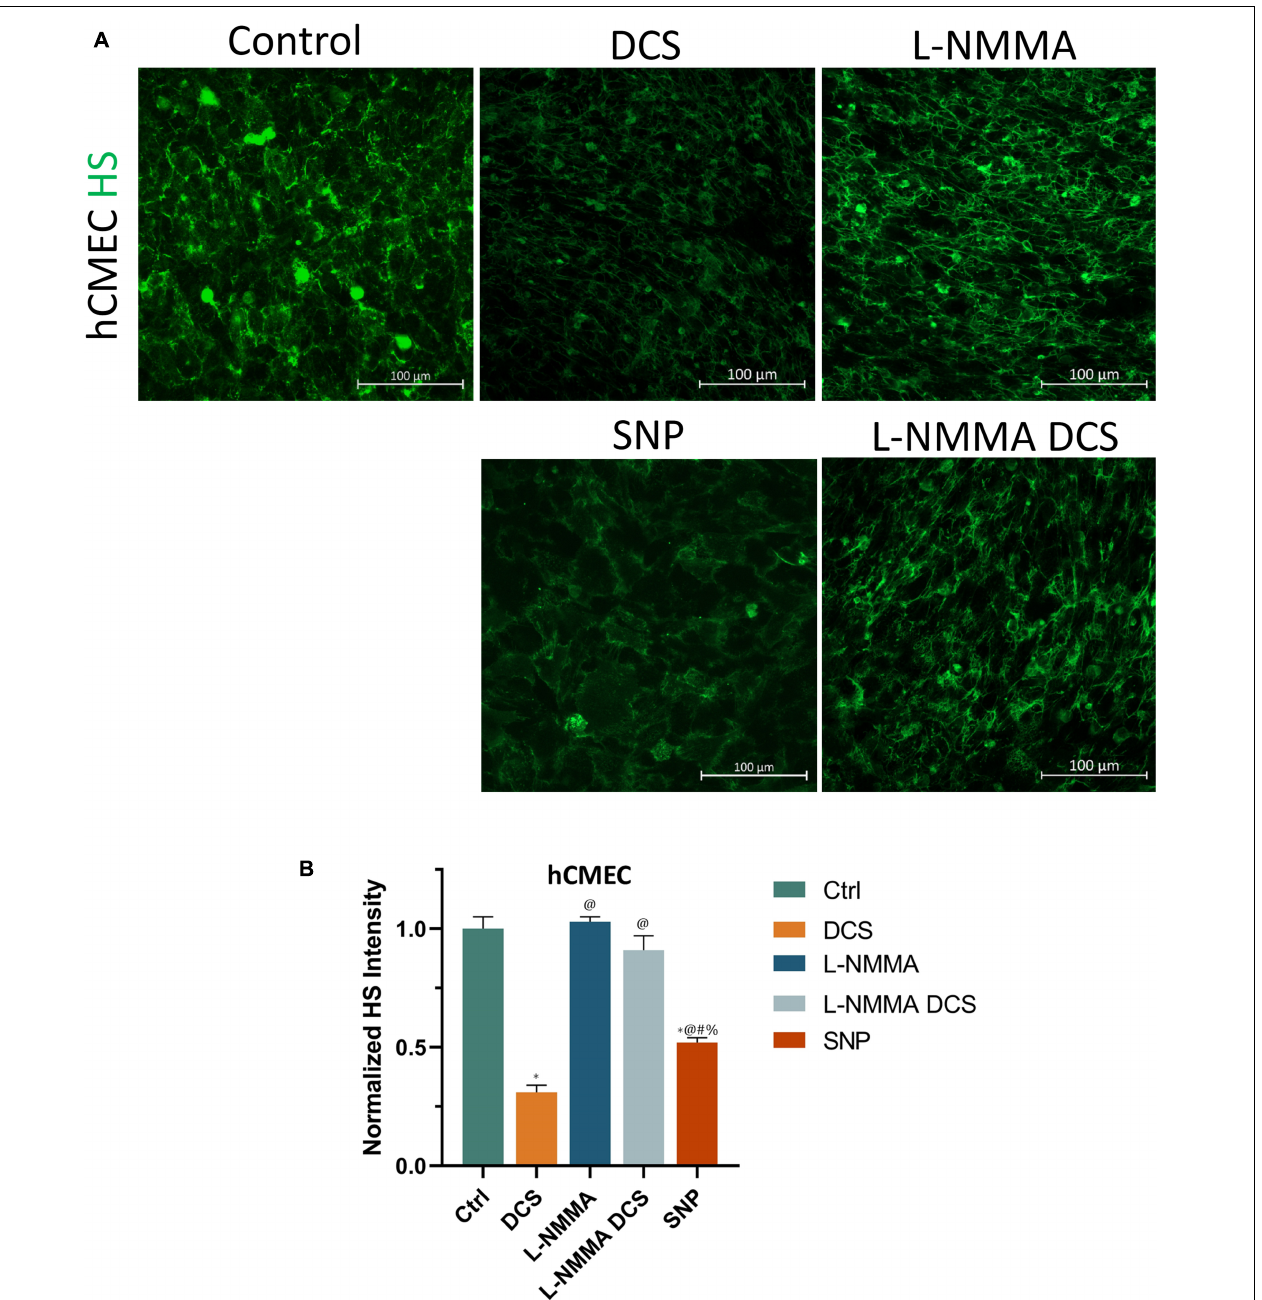
FIGURE 9 | Effects of a NOS inhibitor (L-NMMA) and a NO donor, sodium nitroprusside (SNP) on endothelial glycocalyx (EG) of in vitro BBB formed by hCMEC monolayer. (A) Confocal images of heparan sulfate (HS) of EG on in vitro BBB and (B) comparison of HS intensity under control and after treatment of 10 min 1 mA/cm 2 DCS (DCS), or treatment of 60 min 1 mM L-NMMA, or pretreatment of 60 min 1 mM L-NMMA and treatment of 10 min 1 mA/cm 2 DCS (L-NMMA DCS), or treatment of 30 min 300 µ M SNP (SNP). n = 3 samples for each case in (B) . * p < 0.05, compared with the control, @ p < 0.05, compared with DCS, # p < 0.05, comparing L-NMMA DCS and SNP with L-NMMA, % p < 0.05, comparing SNP with L-NMMA